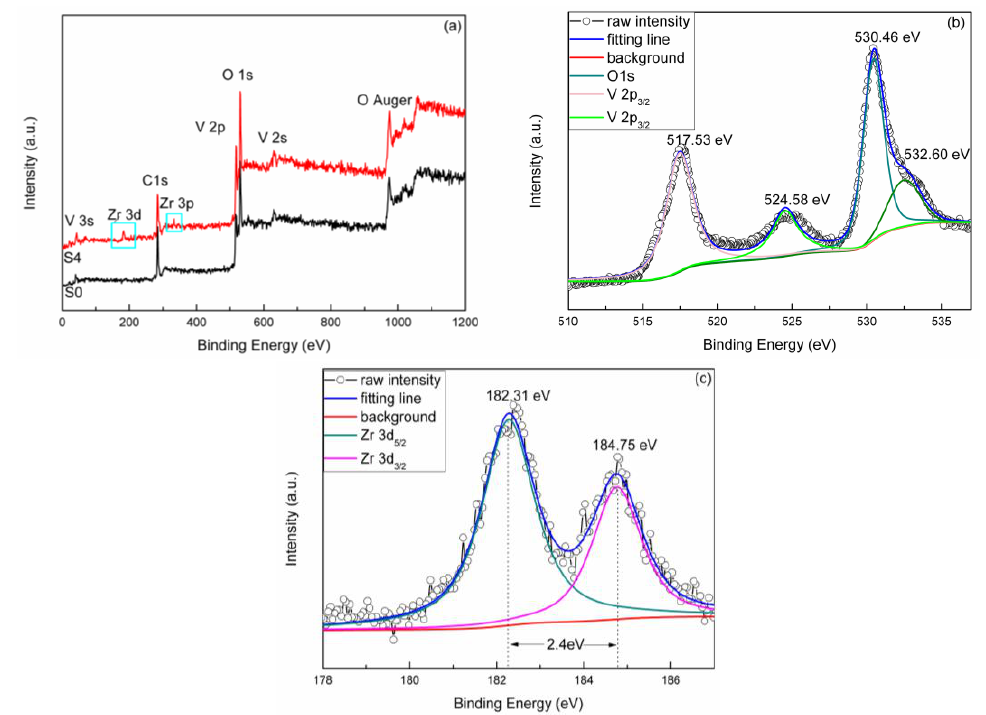
Figure 3. ( a ) XPS (X-ray photoelectron spectroscopy) spectra of un-doped and 4% Zr-doped VO 2 samples with binding energy from 0 to 1200 eV; ( b ) Core level for V 2p and O 1s of 4% Zr-doped VO 2 samples; ( c ) Core level for Zr 3d of 4% Zr-doped VO 2 samples. samples; ( c ) Core level for Zr 3d of 4% Zr-doped VO 2 samples.